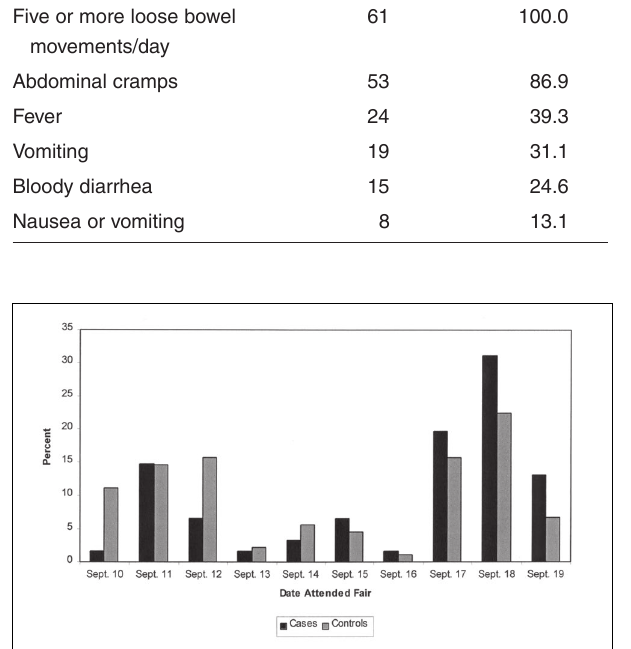
Figure 1) Percentage of cases and controls attending the fair on each day, September (Sept) 1999. Controls were more likely than cases to attend the fair during the first weekend (September 10 to 12), while cases were more likely than controls to attend during the second week- end (September 17 to 19) (P<0.05)